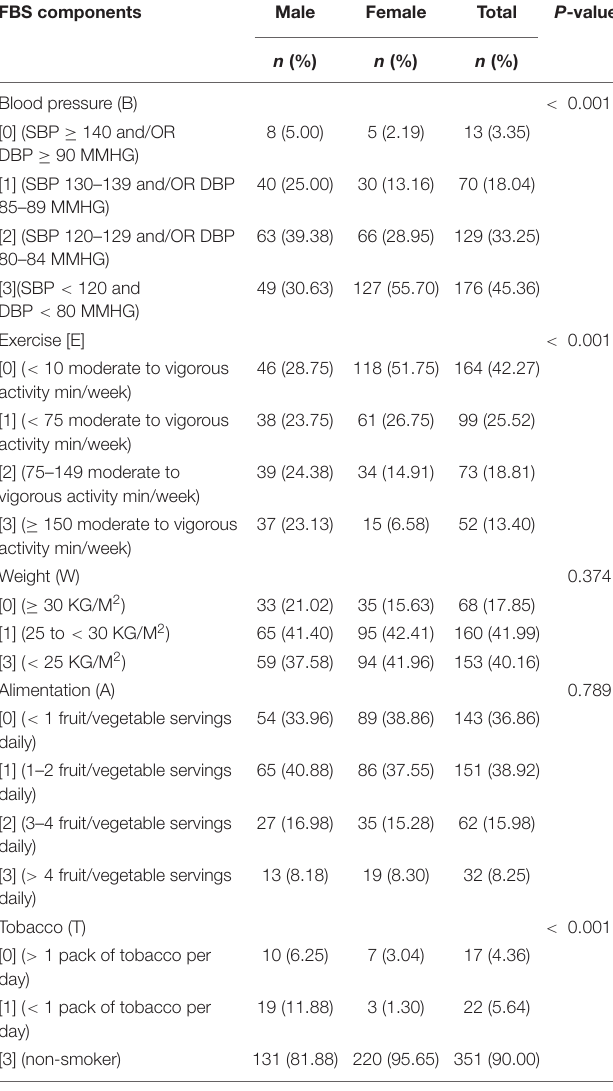
TABLE 1B | Fuster-BEWAT score (FBS): participant characteristics and descriptive statistics by gender ( N = 388). FBS components Male